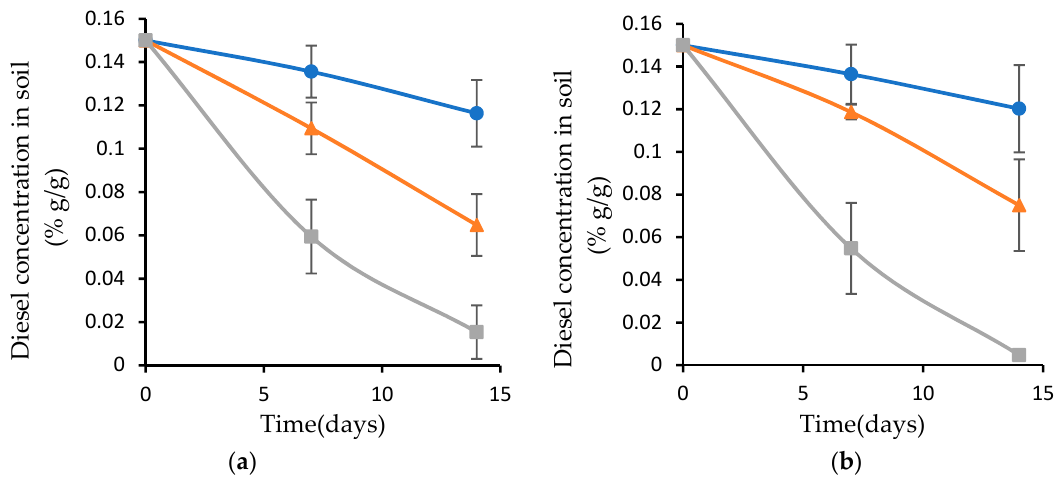
Figure 5. Diesel concentration in the inoculated soil pretreated at 50 ◦ C for 4 h ( a ), and 6 h ( b ), followed by incubation at 37 ◦ C for the rest of the experiment. Soil inoculated with biofilm attached to plasma-treated wood waste (grey); biofilm attached to nontreated wood waste (orange); and planktonic bacteria (blue).